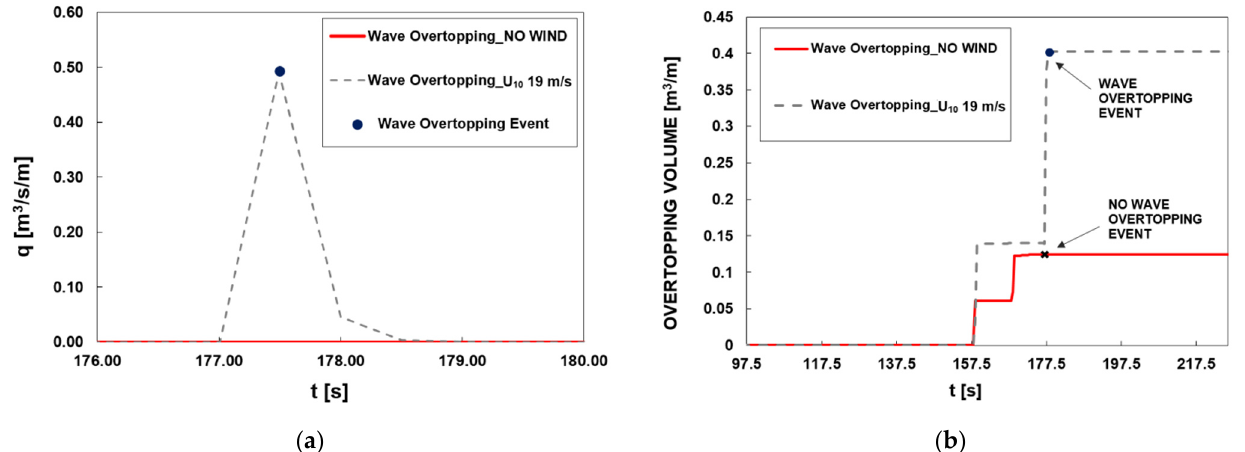
Figure 7. Effects of wind stress on wave overtopping, TEST_3 and Rc +8.50 m. Panel ( a ) wind effects on overtopping discharge; panel ( b ) wind effects on cumulative wave overtopping volume.